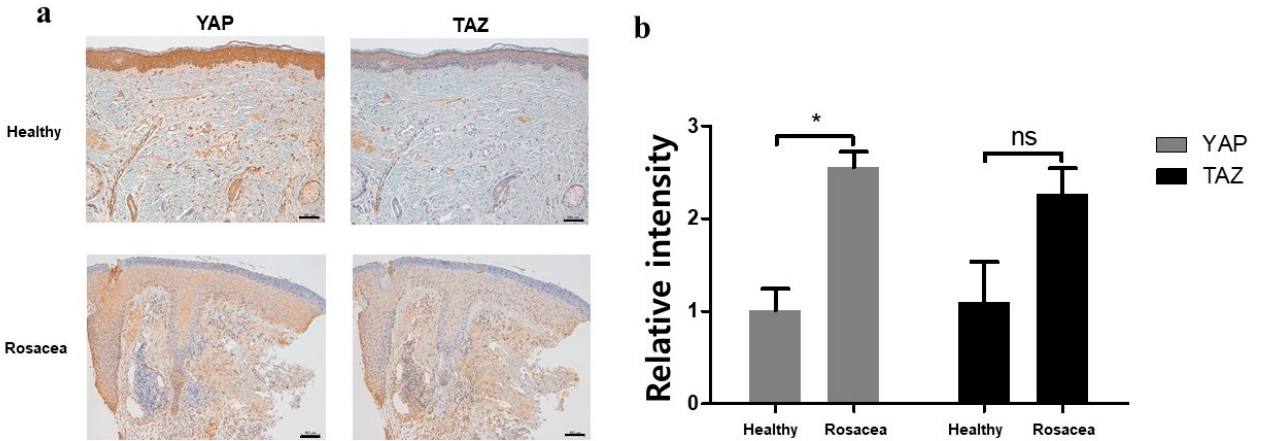
Figure 1. ( a ) Skin samples from patients with rosacea showed high levels of yes-associated protein (YAP) and transcription activator with a PDZ-binding motif (TAZ), compared with samples from healthy volunteers. Original magnification, × 200; scale bar = 100 µ m. ( b ) Immunostaining intensities were calculated with ImageJ software. * means data was significant ( p < 0.05), and ns means nonsignificant.